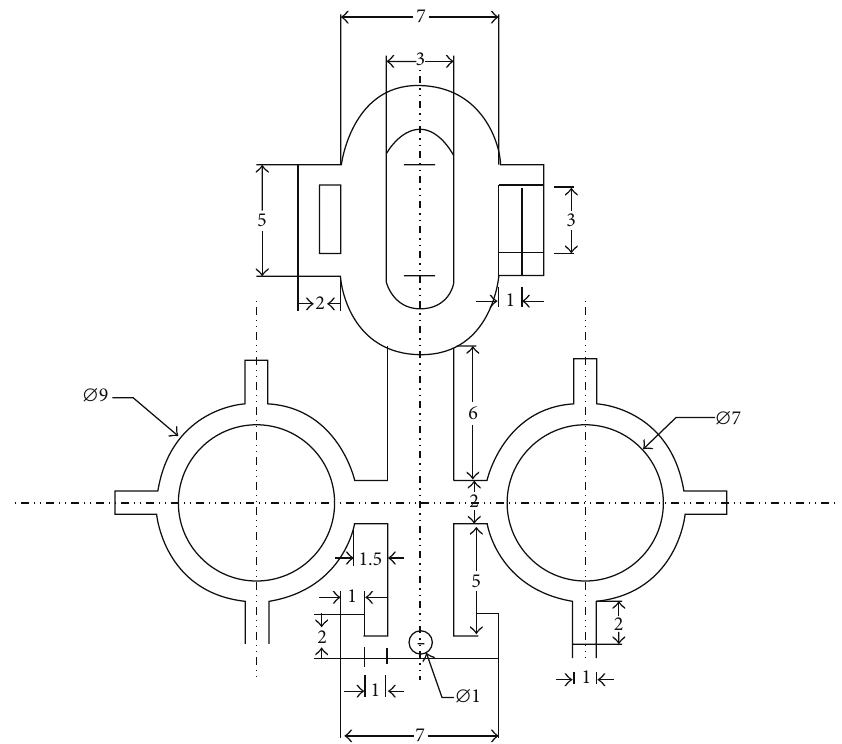
Figure 1: The physical dimensions for the frame (unit: